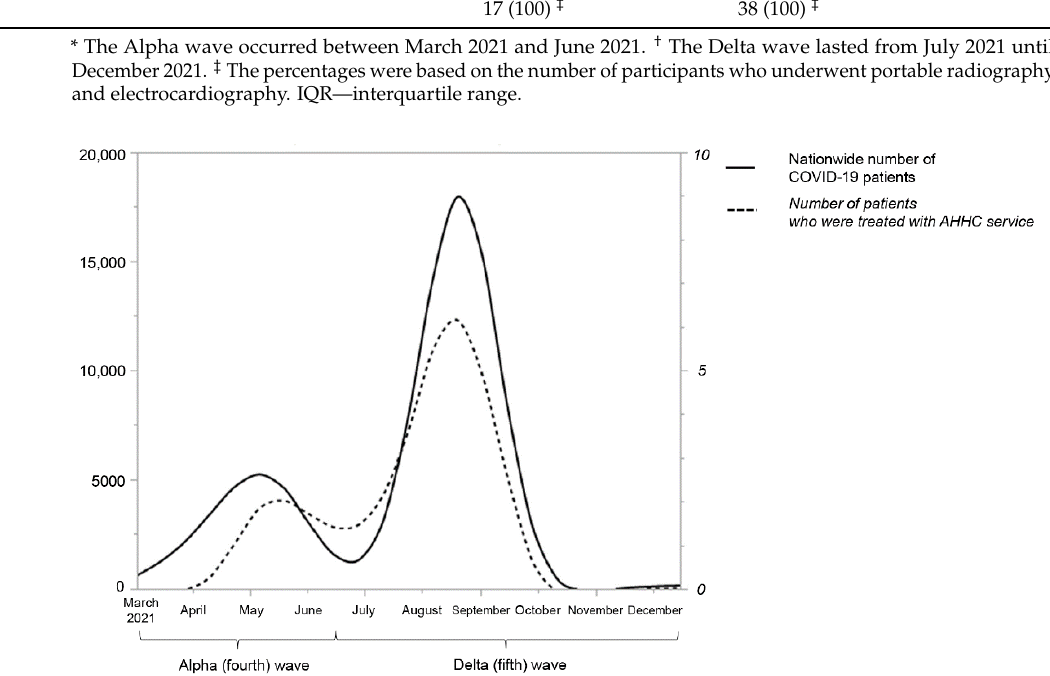
Table 2. Patient vital signs and symptoms at the time of the consultation, according to the wave of the pandemic.